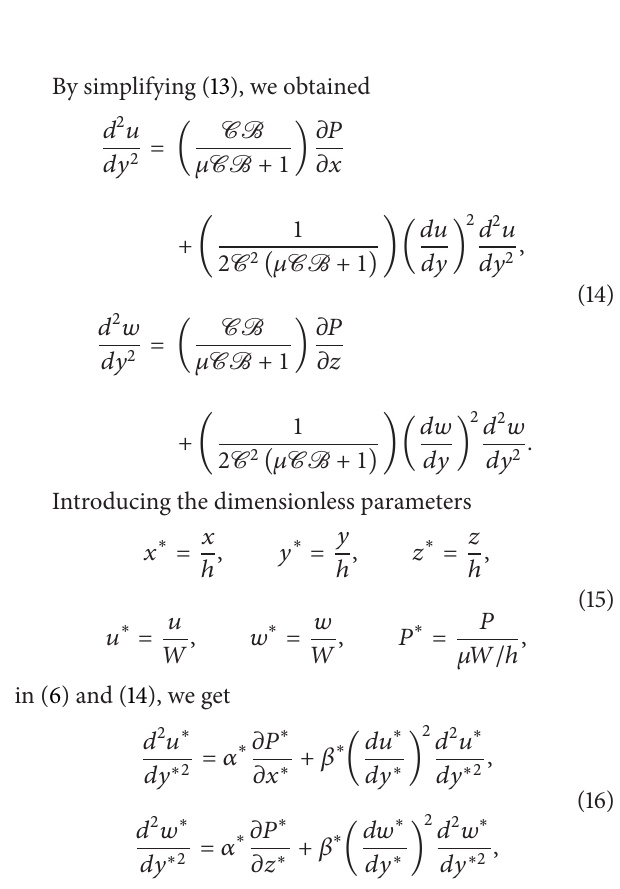
Figure 1: The geometry of the “unwrapped” screw channel and barrel